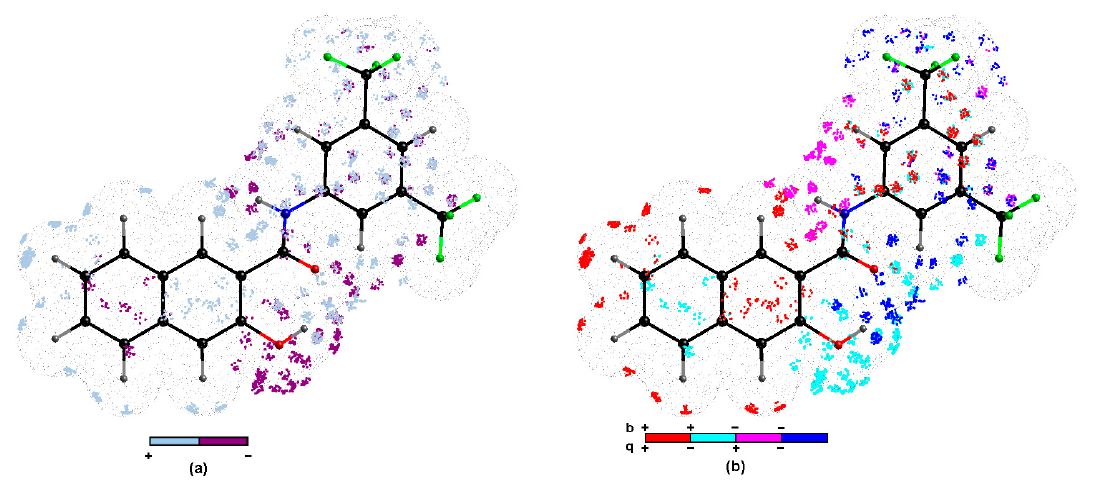
Figure 5. Spatial sectors with largest contribution into MRSA potency selected by CoMSA IVE-PLS for 14 / 8 training / test set samplings. Colors code their contribution ( a ) and four possible combination of mean charge q and correlation coe ffi cient b values ( b ) 1 – 22 carboxamides. Reference compound 13 was illustrated as the most potent molecule.